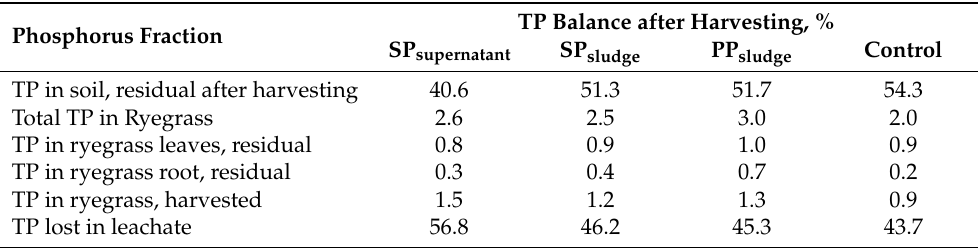
Table 5. Overall phosphorus balance for the